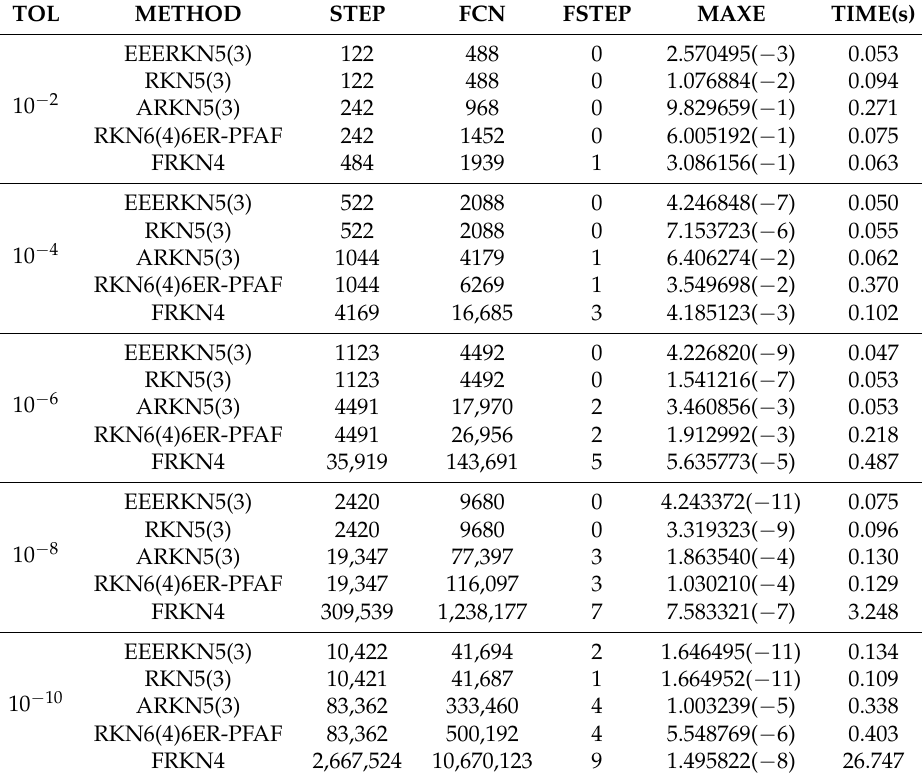
Table 2. Numerical results for Problem